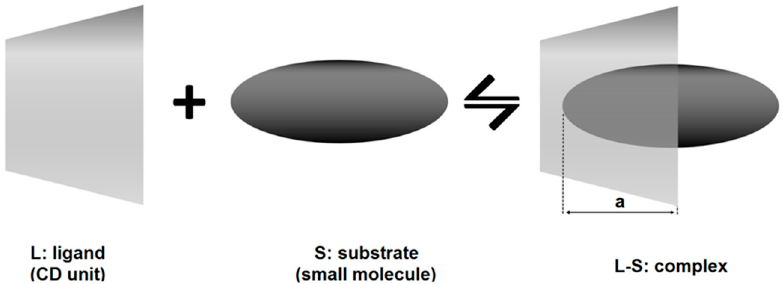
Figure 2. Schematic representation of the inclusion mechanism of complexation between CD (the ligand, L) and a small molecule (the substrate, S) in the case of 1:1 stoichiometry (molar ratio). The depth (a) that the substrate molecule can reach in the CD cavity varies according to the substrate physicochemical properties and CD steric hindrance.